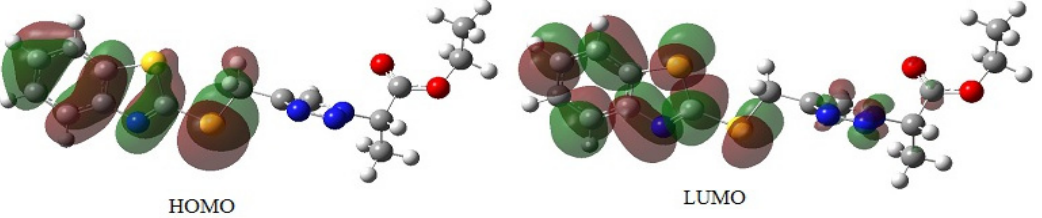
Table 4. The electronic data at the B3LYP/6-31 + G(d, p ) level for 5e in DMSO. Parameter Value Energy (Hartree)